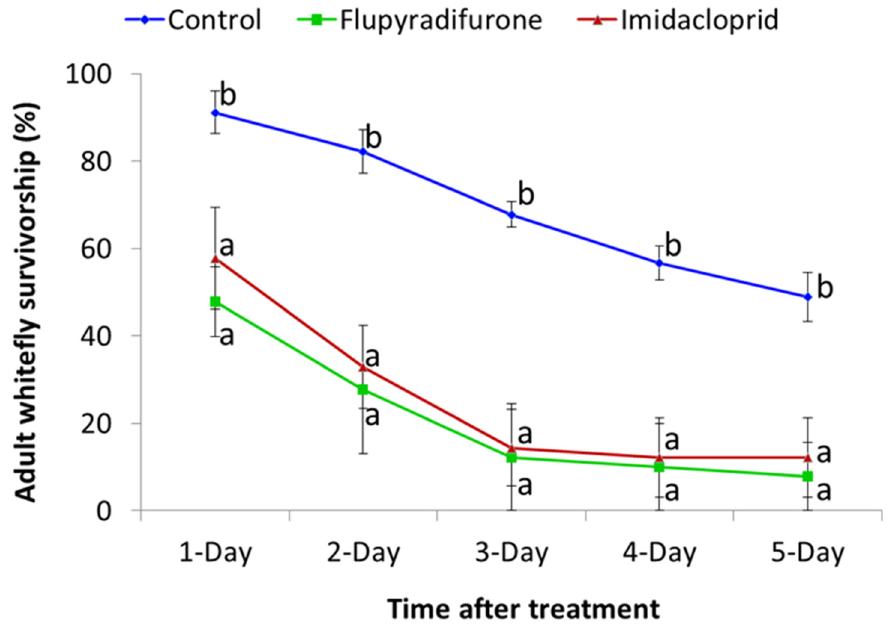
Figure 1. Survivorship of adult B. tabaci introduced to leaf disc assays and monitored at regular intervals up to five days after treatment with 15 g a.i/100 L imidacloprid and 15 g a.i/100 L flupyradifurone (Mean ± SE). Means with the same letter for a given time after treatment are not significantly different ( p < 0.05, Tukey–Kramer test).